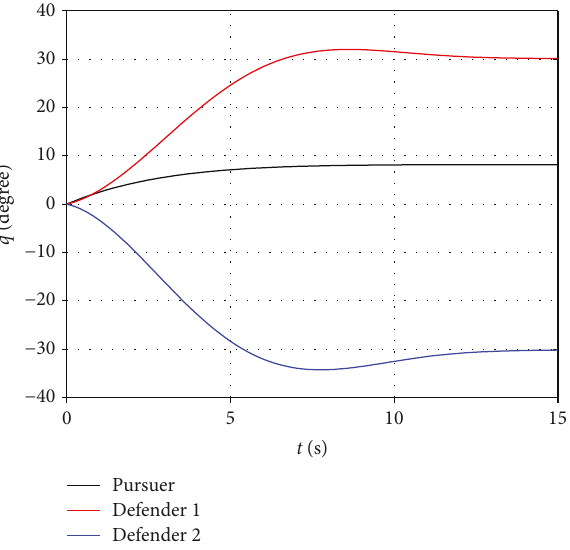
Figure 16: Intercept angle variation of the